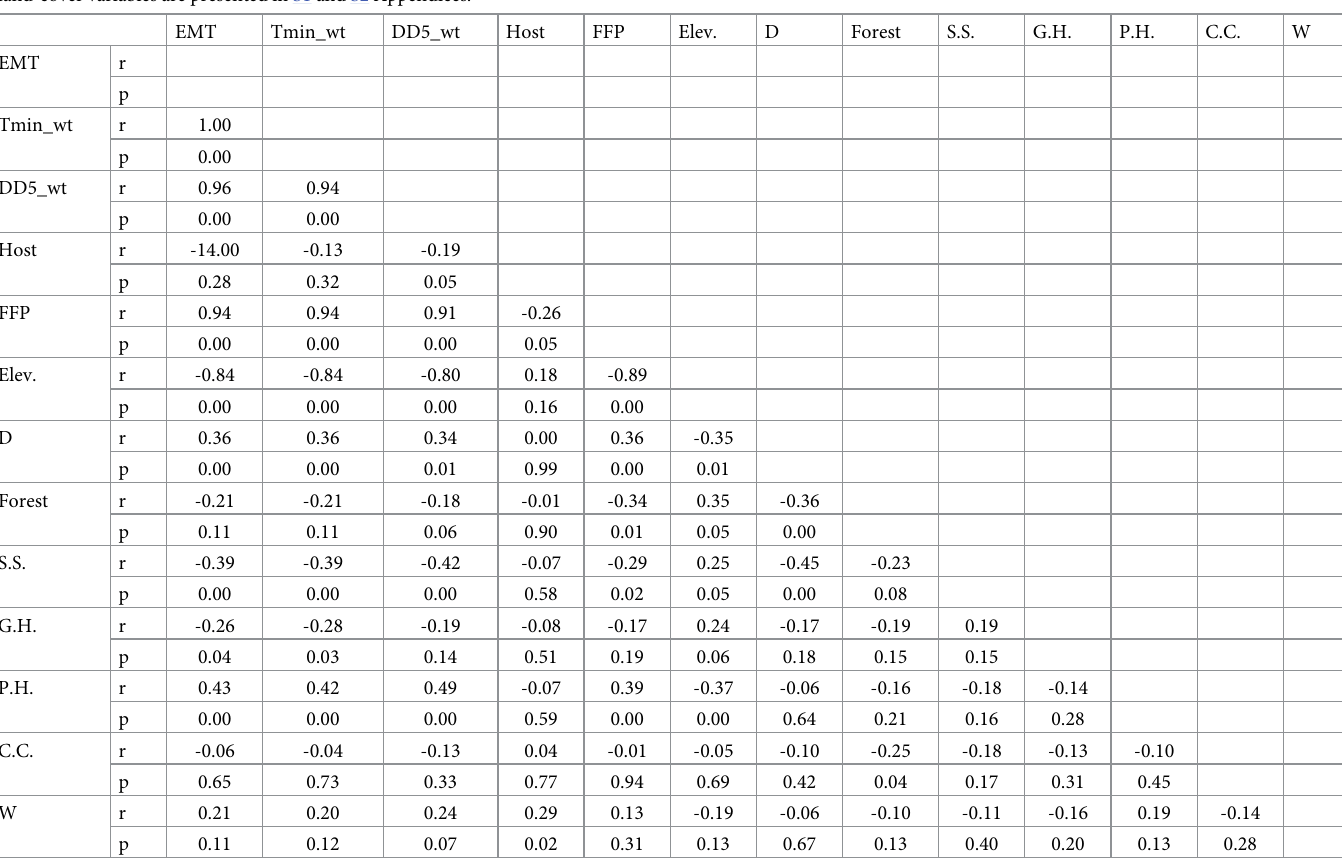
Table 1. Pearson’s correlations (r) and p values for R . pomonella . Results show that the climate variables were correlated with each other. Tmin_wt = winter mean min- imum temperature, DD5_wt = winter degree-days below 5˚C, FFP = frost free period, Host = host plant abundance, Elev. = elevation, D = developed, S.S. = shrub-scrub, G.H. = grassland-herbaceous, P.H. = pasture-hay, C.C. = cultivated crops, Forest = evergreen, deciduous, and mixed forests, and W = wetland. Barren land and open water land-cover categories, which were both non-correlated and not included in the analysis, are not shown here due to space limitations. Complete descriptions of climate and land-cover variables are presented in S1 and S2